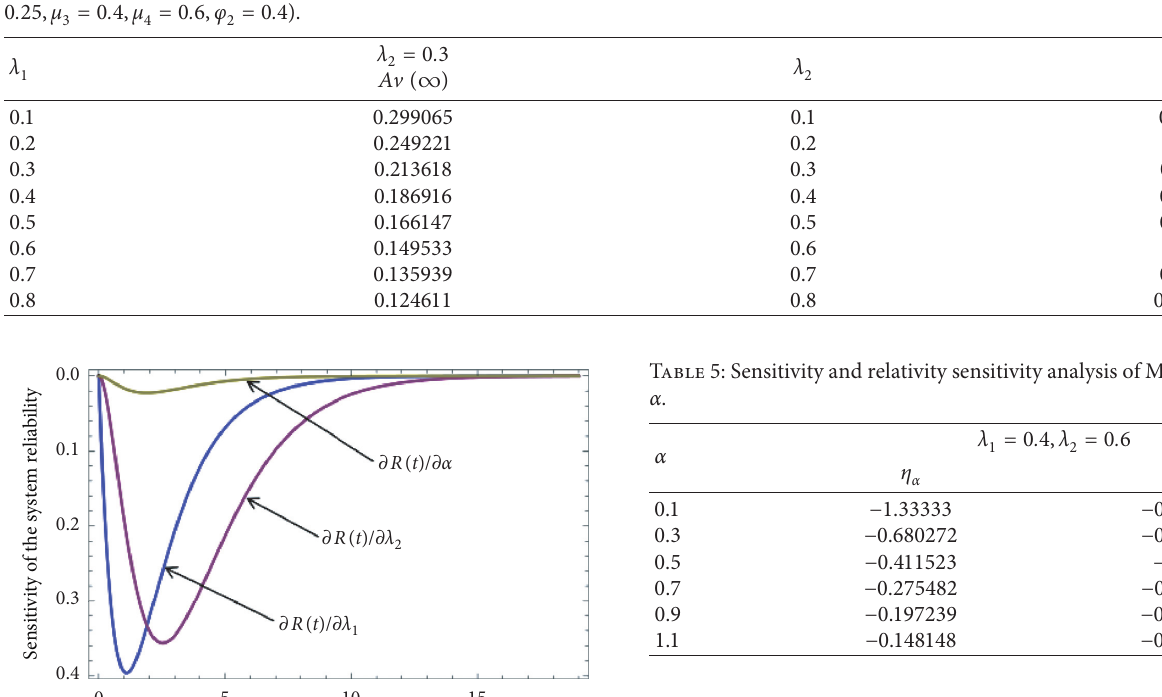
Table 4: The steady-state availability for different values of λ